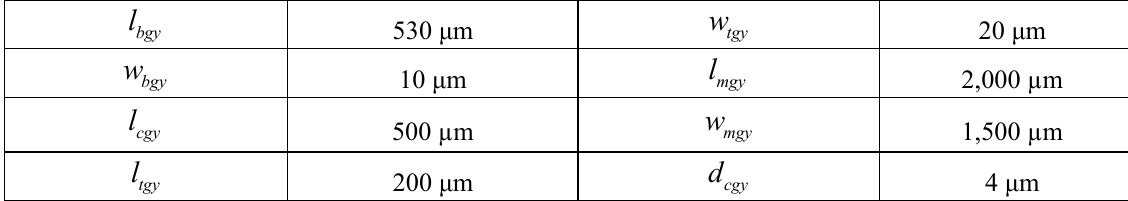
Table 6. Dimensions of X/Y-axis gyroscope.